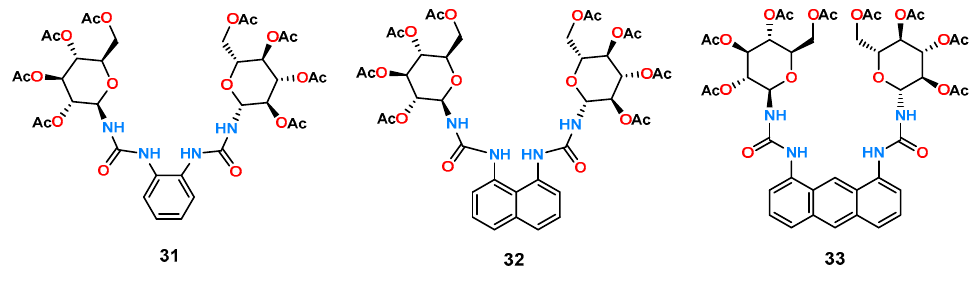
Figure 12. Urea-glucopyranose receptors 31 – 33 .